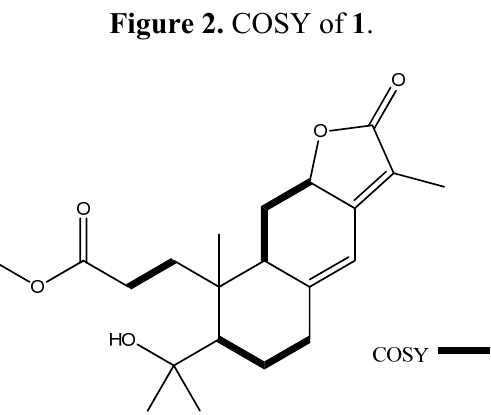
Figure 2. COSY of 1 .